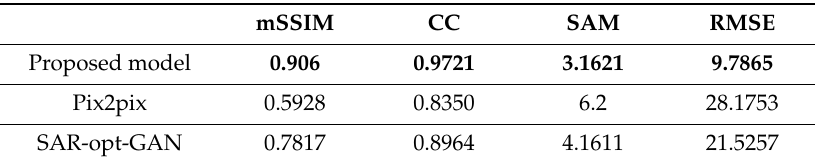
Table 2. Quantitative Evaluation of Models on Dataset